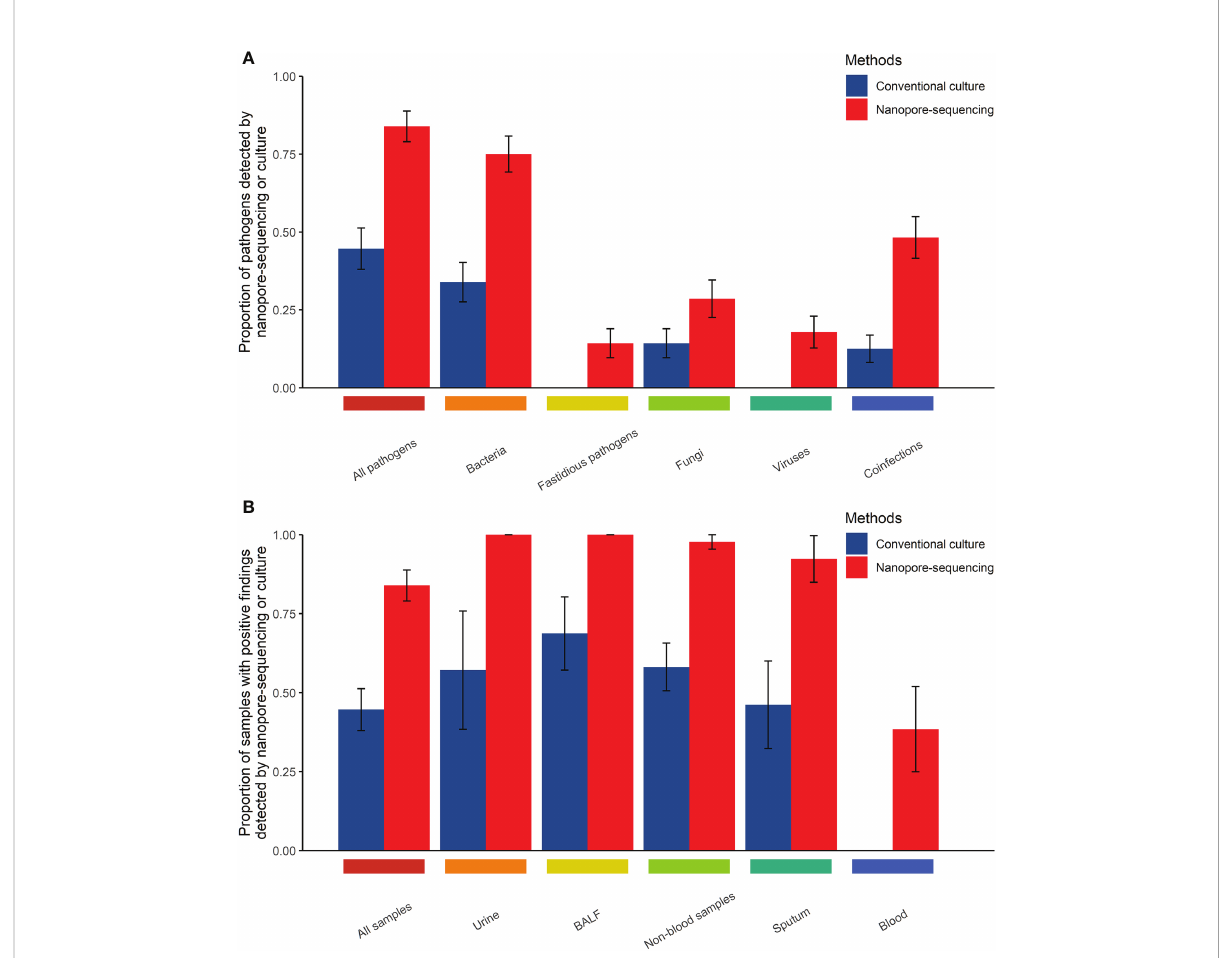
FIGURE 1 Comparison of the performance of those two methods in detecting pathogens in body fl uid samples from immunocompromised cancer patients with suspected infections ( A , Comparison of the performance of those two methods in detecting pathogens by types of pathogens; B , Comparison of the performance of those two methods in detecting pathogens by types of